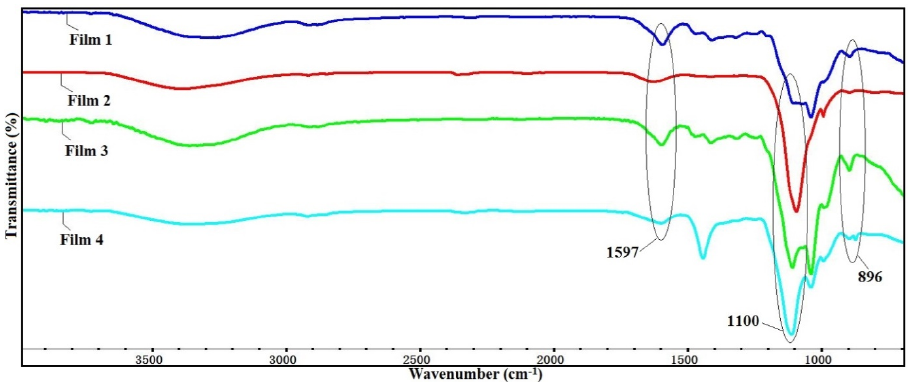
Figure 2. The FT ‐ IR spectra of four blended films.